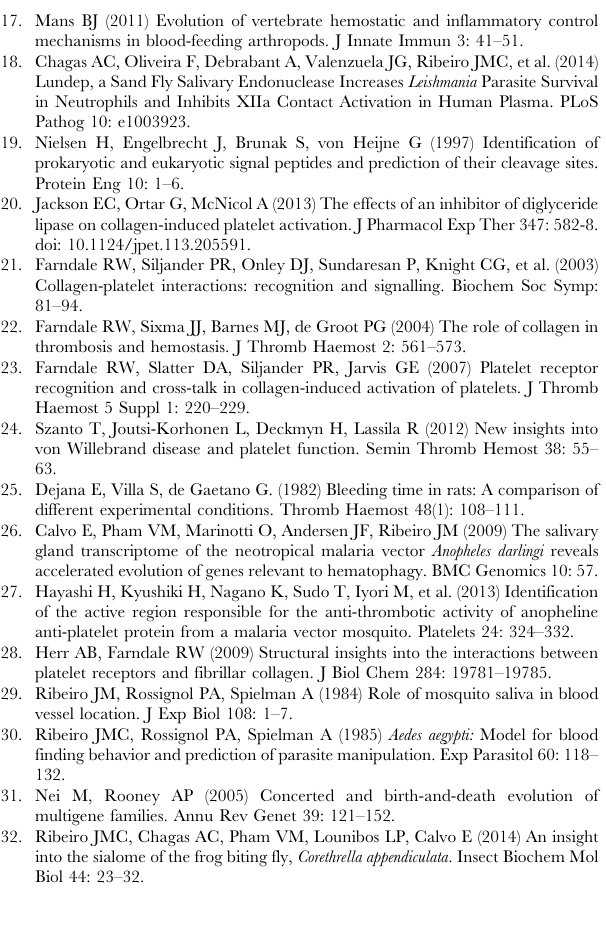
Figure S2 Simplagrin-CT and Aegyptin C-terminal domains are structurally similar. (A) Three-dimensional structure prediction of Simplagrin-CT and Aegyptin C- terminal domain showing a ribbon diagram of the model generated using PyMOL. Coordinates were generated auto- matically by I-TASSER software. (B) Surface density map of Simplagrin-CT and Aegyptin C-terminal domain generated by PyMOL APBS tools. Electrostatic potential surfaces of